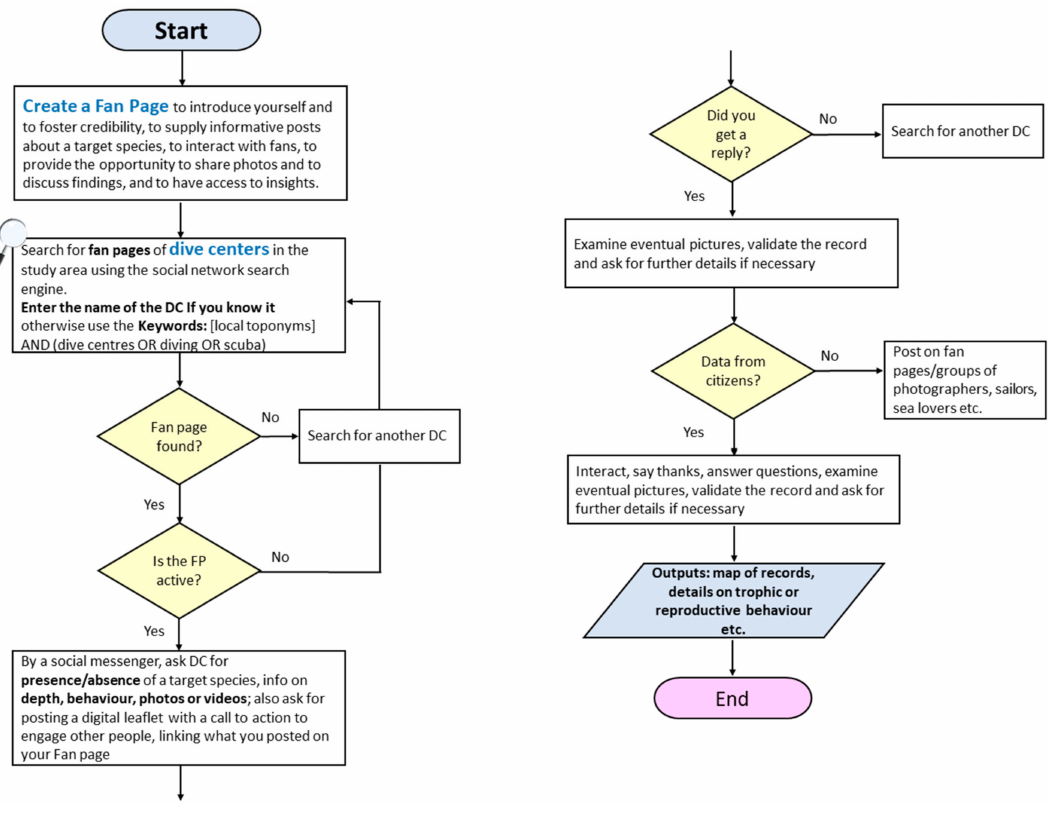
Figure 3. Protocol to engage potential citizen scientists through the social network Facebook. Flow chart illustrating steps applied in this study is